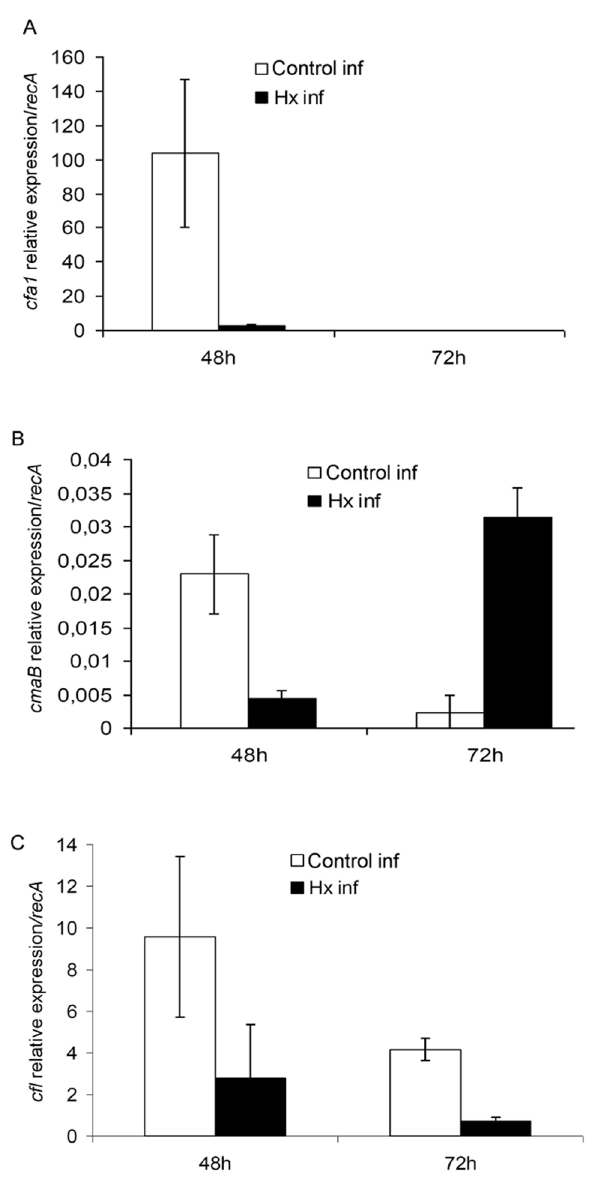
Figure 8. Hx acid treatment reduces expression of COR synthesis genes. The relative expression level of cfa1 (A), cmaB (B) and cfl (C) were measured at 48 and 72 h postinoculation, using qRT- PCR with specific primers. The gene expression was normalized with recA that was used as endogenous references. The results represent the means of three different experiments with standard